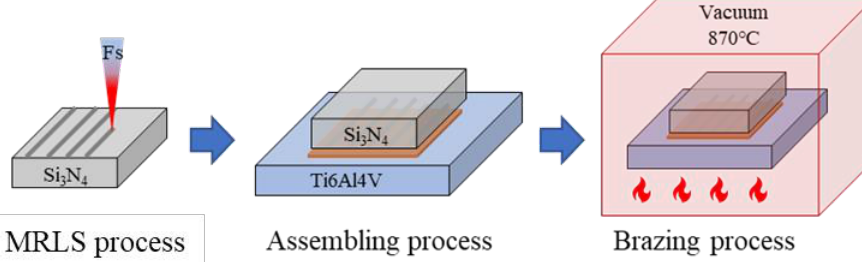
Figure 1. Schematics of MRLS fabrication and brazing process.